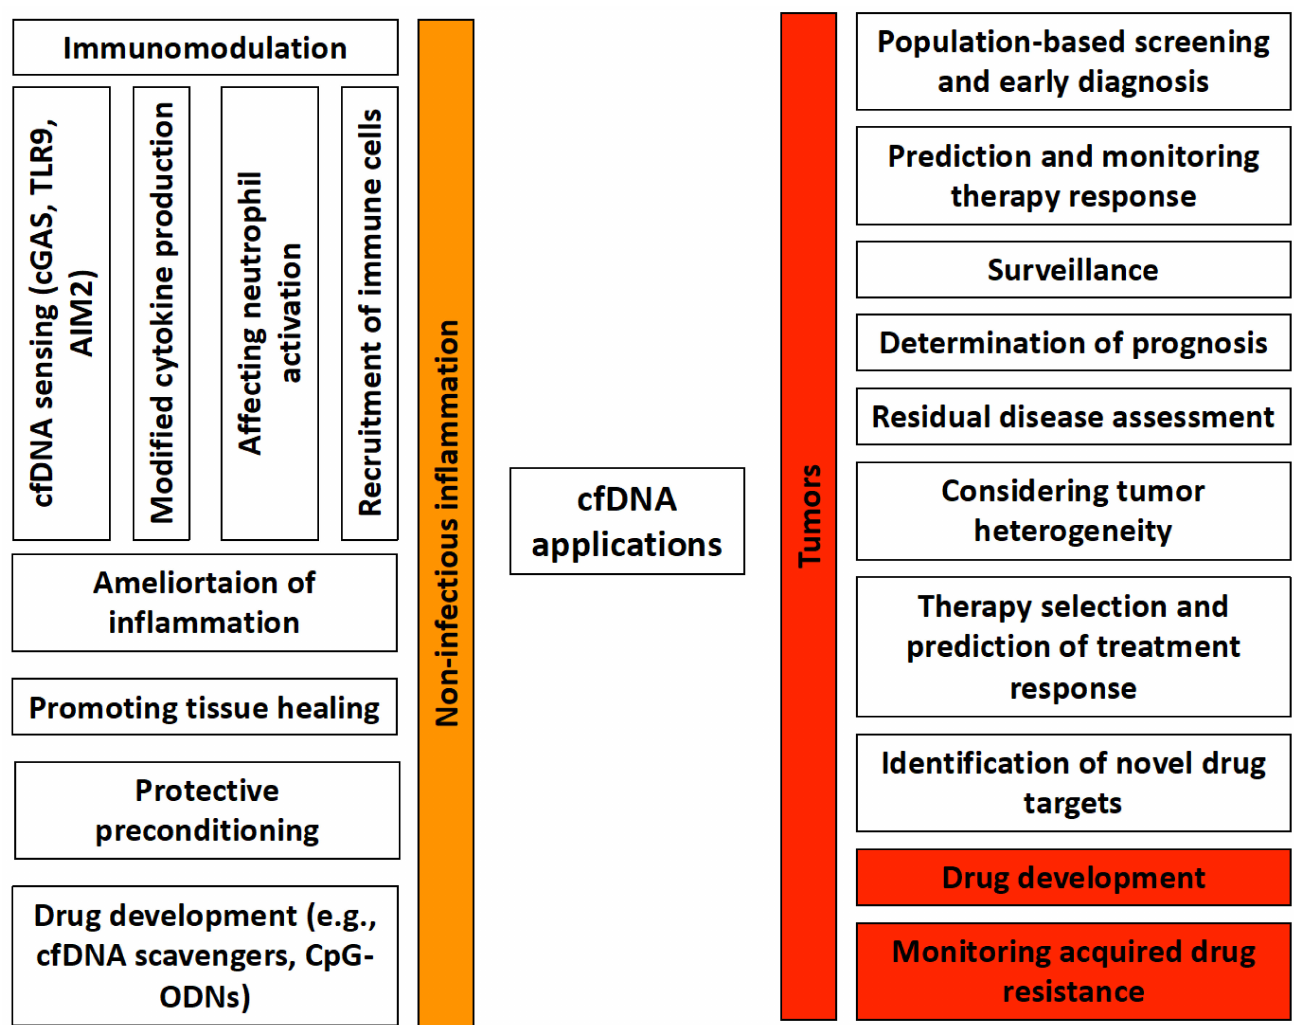
Figure 1. Potential clinical and experimental applications of cfDNA in non-infectious inflammations and tumors. cfDNA has an immunomodulatory effect in non-infectious inflammations, which is mediated by cfDNA sensing, changes in cytokine production, neutrophil activation, and effects on other